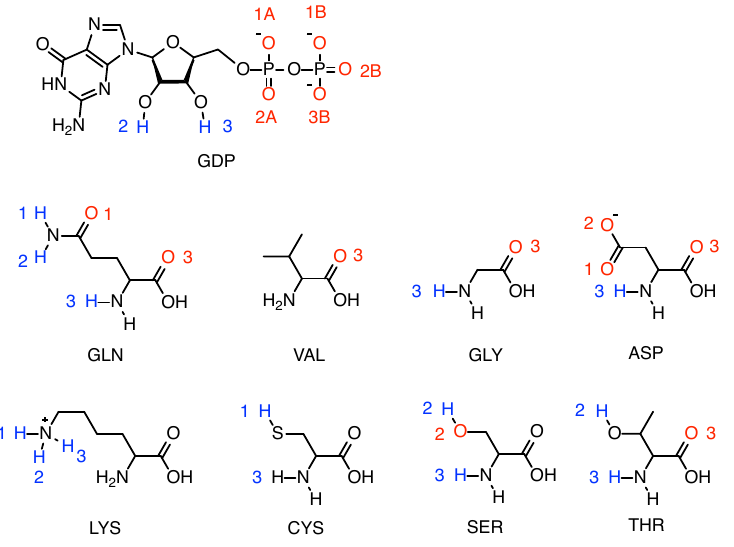
Figure A2. Sketches of GDP, and amino acid residues of KRAS protein mentioned in the